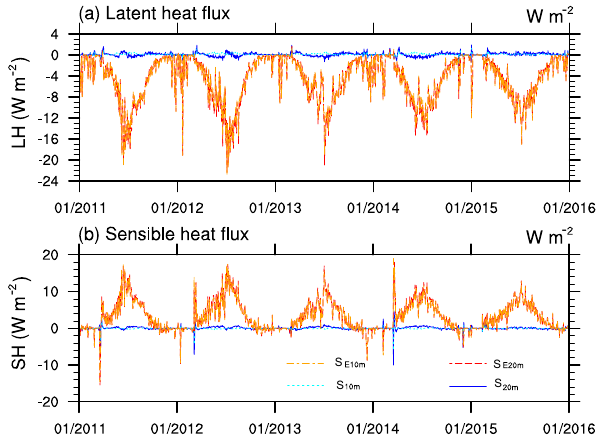
Figure 13. Deviations of simulated domain-average latent heat and sensible heat fluxes from those simulated by S 2m (for S 10m and S 20m ) and by S E2m (for S E10m and S E20m ) .